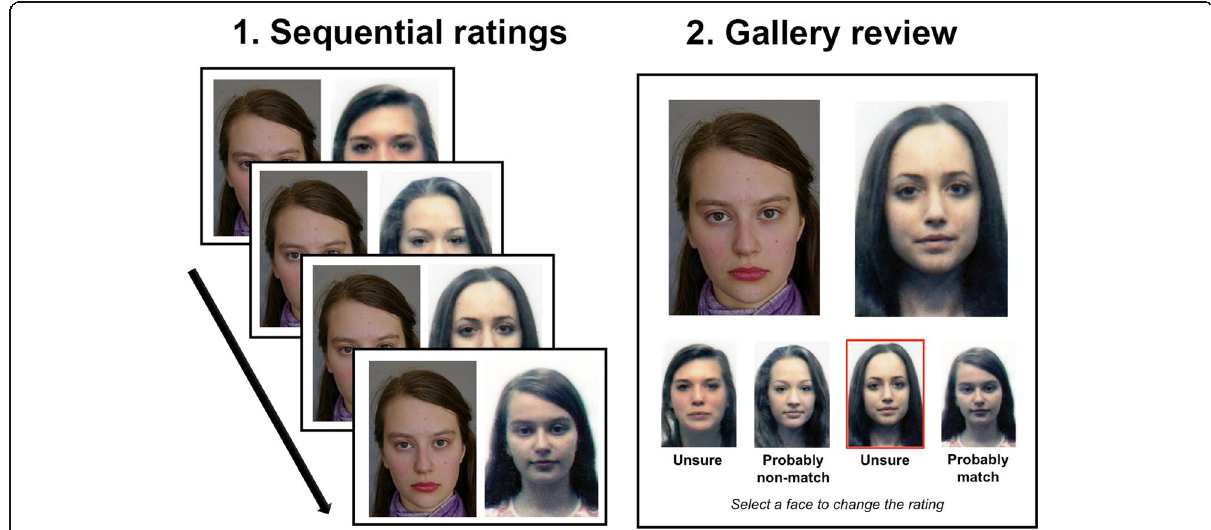
Fig. 1 An illustration of the trial design in the Face Recognition Candidate List Review Task (FR-Task). This task simulated the workflow of passport officers using face recognition software to screen for identity fraud in passport applications. On each trial, participants were asked to review four faces that have been flagged by the software as potential matches to the ‘ applicant ’ . Participants made sequential pairwise similarity ratings by comparing the four faces to the applicant (left), before reviewing and confirming these ratings in a gallery review screen (right). The images shown are representative of the images presented to participants, but for privacy reasons we are unable to reproduce the passport images